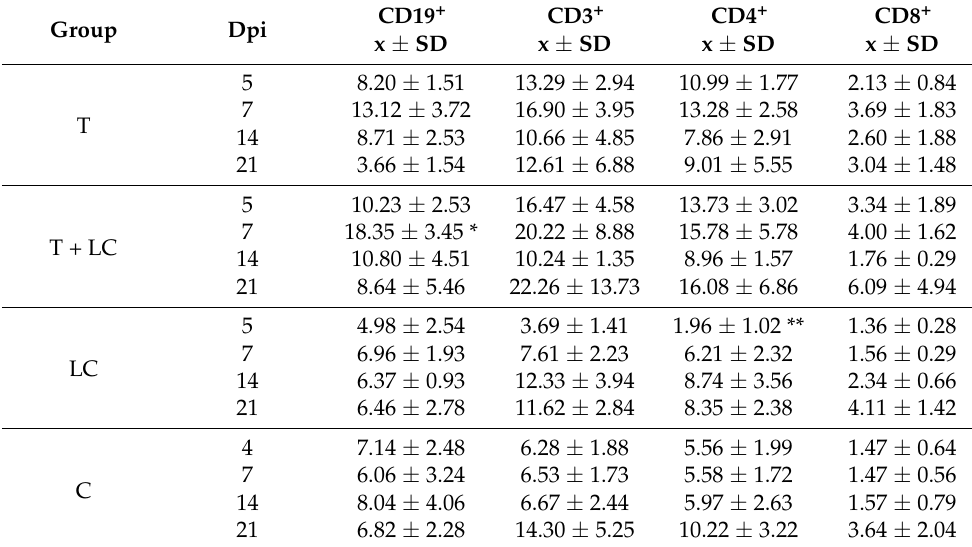
Table 4. The absolute count (cells × 10 6 ) of mesenteric lymph nodes (MLN) lymphocytes B (CD19 + ) and T (CD3 + , CD4 + , CD8 + ) in groups of mice: infected with T. spiralis (Group T), infected with T. spiralis and receiving LC (Group T + LC), uninfected with T. spiralis and receiving LC (Group LC) and uninfected mice (control) (Group C). Mean values ( n = 6) and standard deviations are presented. * p < 0.05, ** p <